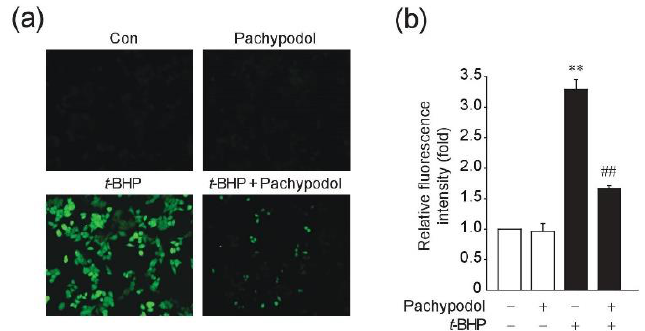
Figure 3. Effects of pachypodol on the ROS production. HepG2 cells were exposed to 500 μM t -BHP for 30 min following the 12 h-pretreatment of pachypodol. The intracellular ROS generation was determined by fluorescence microscopy after cells were stained with CM-H 2 DCFDA (10 μM). The representative images ( a , 20×) and the quantified fluorescence intensities ( b ) are shown. Data represent the mean ± S.D. ( n = 3). ** p < 0.01 (compared with the DMSO-treated vehicle control); ## p < 0.01 (compared with the group treated with t -BHP alone); CM-H 2 DCFDA, 5-(and-6)-chloromethyl-2 (cid:48) ,7 (cid:48) -dichlorodihydrofluorescein diacetate acetyl ester.